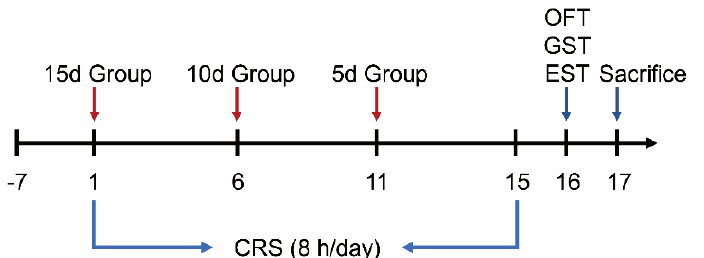
Figure 1. Experimental design of CRS-induced fatigue. Group CRS (15 day) was restrained on day 1, while group CRS (10 day) and group CRS (5 day) were restrained on day 6 and 11, respectively.